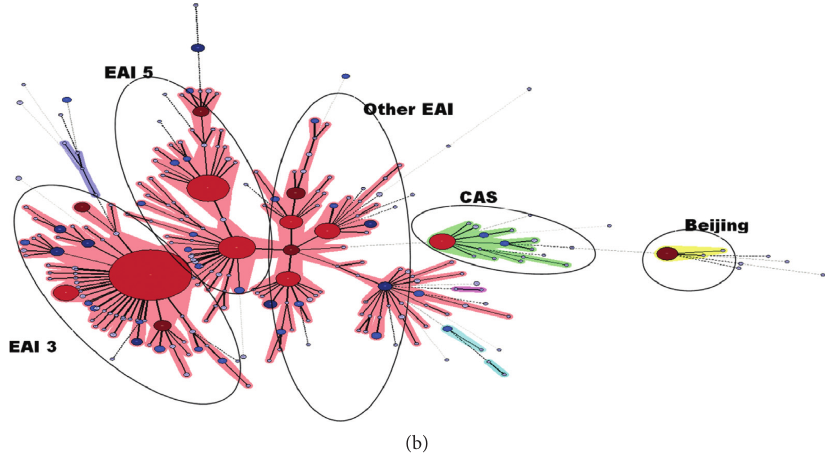
Figure 3: (a) Phylogenetic tree for the recent survey conducted between 2015 and 2018, showing continuous predominance of the EAI3_IND 11 cluster; it also shows the increase in EAI1_SOM 48 strains in this region. (b) A minimum spanning tree (MST) illustrating the distribution of spoligotypes prevalent in Tiruvallur, South India, from 2001 to 2003. The major spoligotypes are labelled against the cluster depicted by the oval. The pink shadow represents East African Indian lineage, green shadow is for Central Asian (CAS) lineage, and the yellow shadow is for Beijing. The structure of the tree is represented as branches and circles representing each individual pattern The colour of the circle is proportional to the number of clinical isolates in our study, illustrating unique isolates as colourless versus coloured clustered isolates (sky blue ≤ 2, deep blue ≤ 5, navy blue ≤ 10, maroon ≤ 20, and red > 20), and also the size of the circle is proportional to the number of strains in the